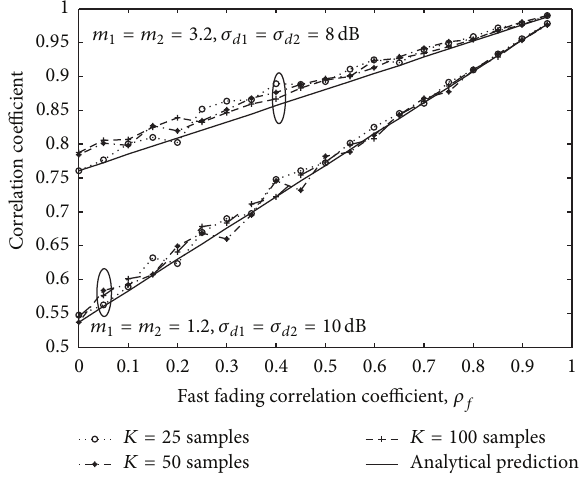
Figure4:Correlationcoefficientandmeanofthesamplecorrelation coefficient as a function of the fast fading correlation coefficient for = 𝑚 = 1.2 , 𝜎 = 𝜎 = 10 dB and 𝑚 = 𝑚 = 3.2 , 𝑚 1 2 𝑑1 𝑑2 1 2 = 𝜎 = 8 dB. The correlation coefficient (analytical prediction) 𝜎 𝑑1 𝑑2 is in solid lines and the mean of the sample correlation coefficient in dashed lines. The number of observations is 𝑁 = 100000 and the number of samples is 𝐾 = 25, 50, 100 .